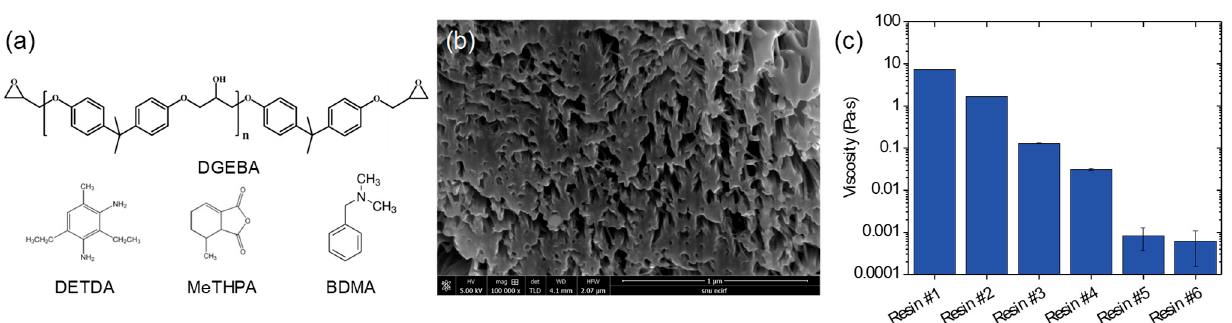
Figure 1. ( a ) Chemical structures of the epoxy resin and curing agents. ( b ) Cross-section image of as-densified CNTF. ( c ) Viscosities of the six resins used in this work.